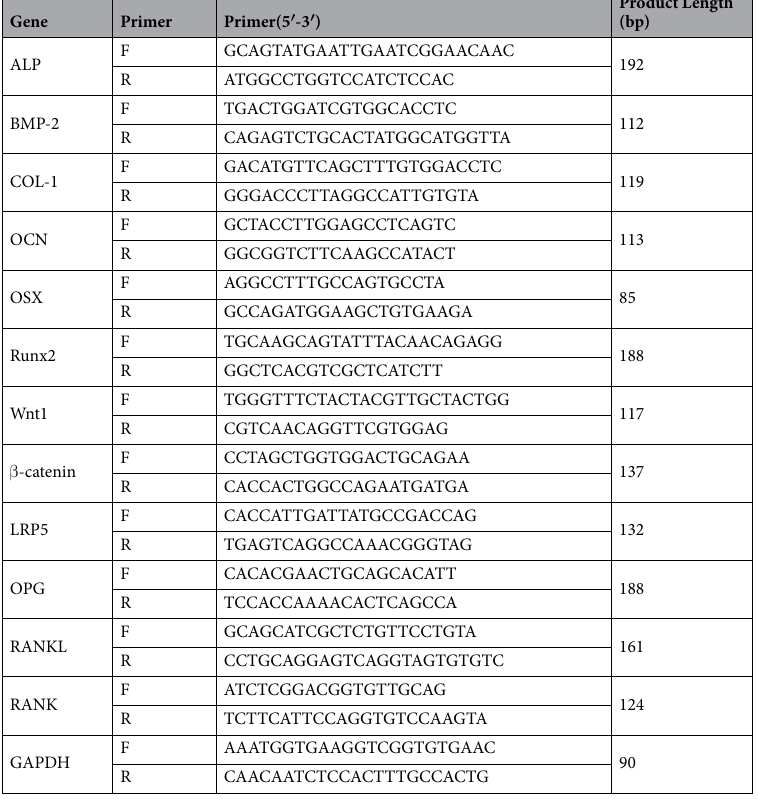
Table 1. The sequence of primers used in the present study for real-time